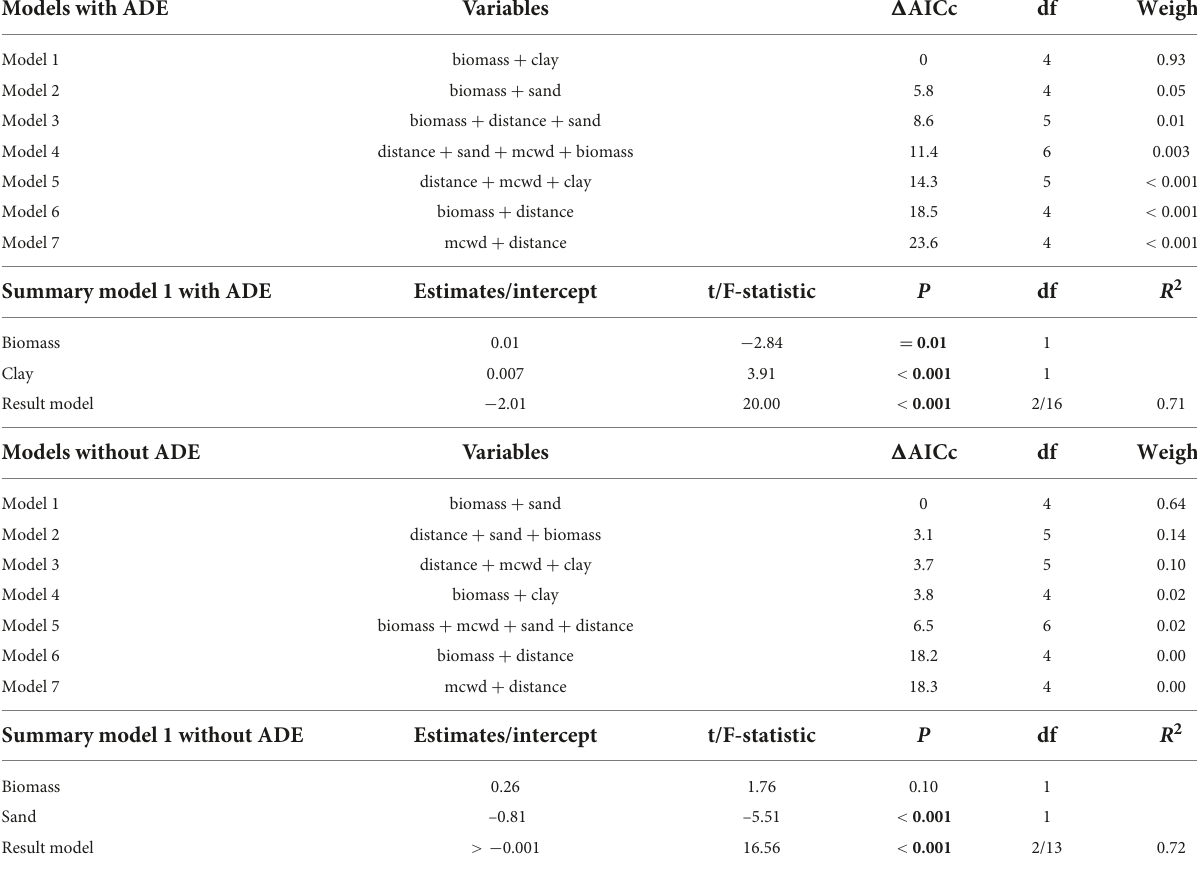
TABLE 2 Models with and without ADE plots to estimate soil